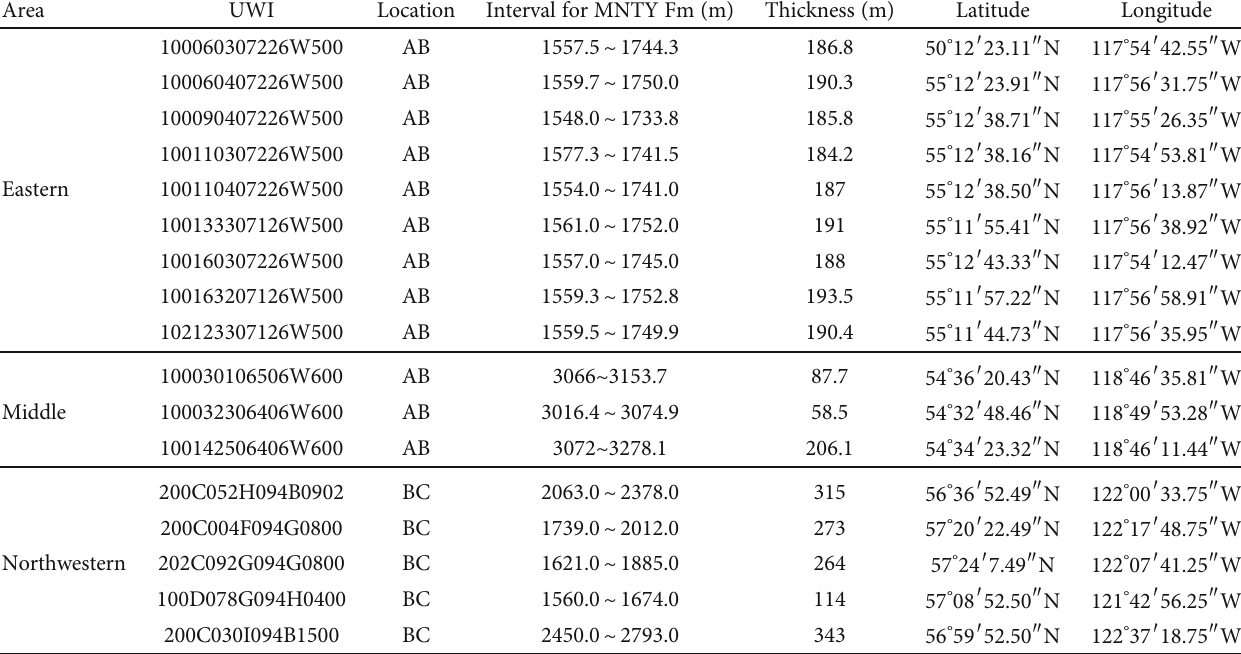
Table 1: Basic well information used in this study. UWI: Unique Well Identi fi er; MNTY Fm: Montney Formation. Area UWI Location